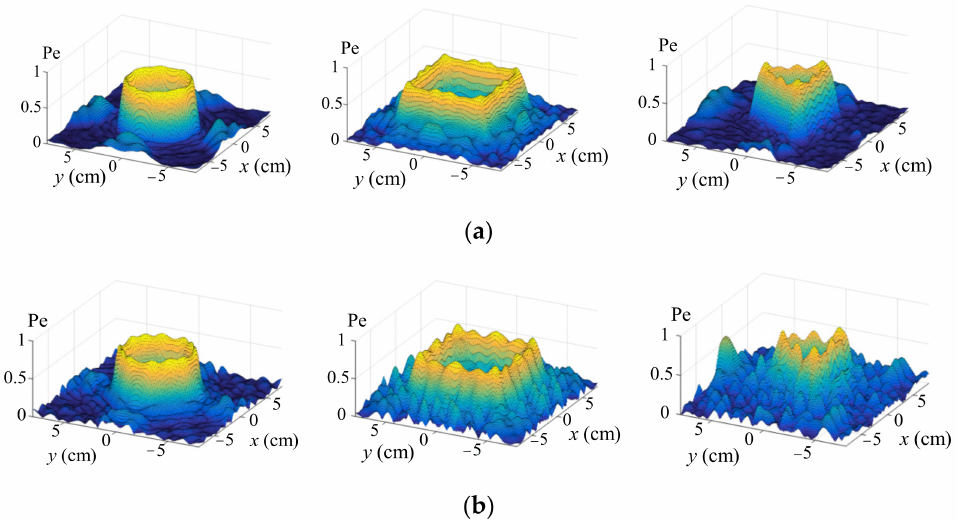
Figure 8. Pressure amplitude comparison with and without optimization. ( a ) is the ultrasound pressure distribution without optimization, and ( b ) is the result with